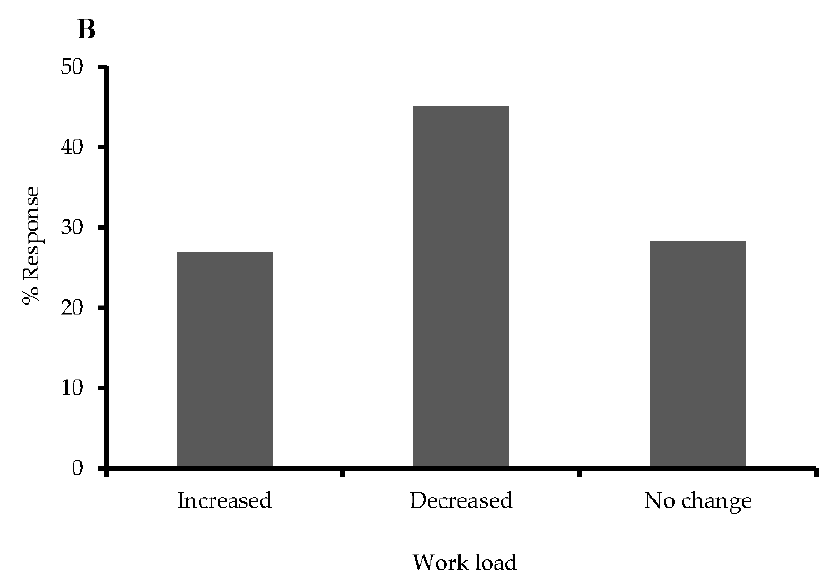
Figure 4. Farmers’ perception of ( A ) motivating factors for adoption of the push-pull technology and ( B ) workload in implementing push-pull technology in the Hawassa district, Ethiopia.